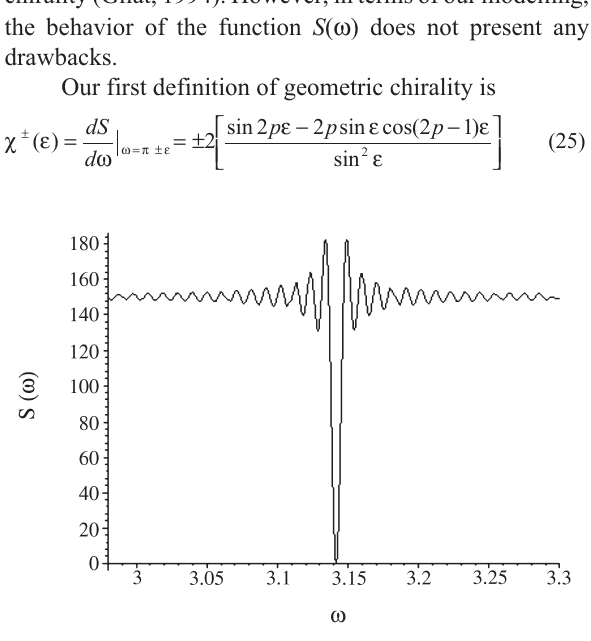
Figure 4 - The surface χ ( ω , α ) - volume of a tetrahedron unit cell - the chirality